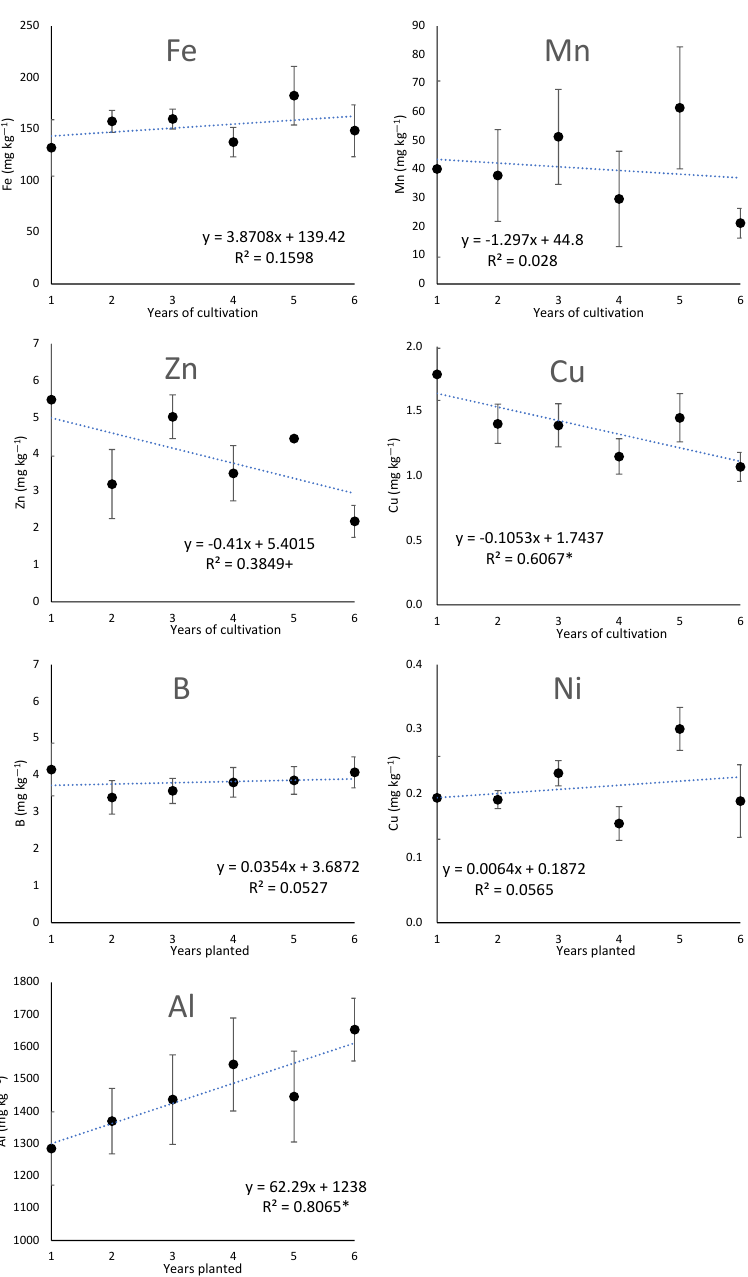
Figure 6. Relationships between years of ginseng cultivation and trace elements and soluble Al in the soil. Mean values ± standard errors ( n = 3). + Represents significance at the 0.10 probability level. * Represents significance at the 0.05 probability level.